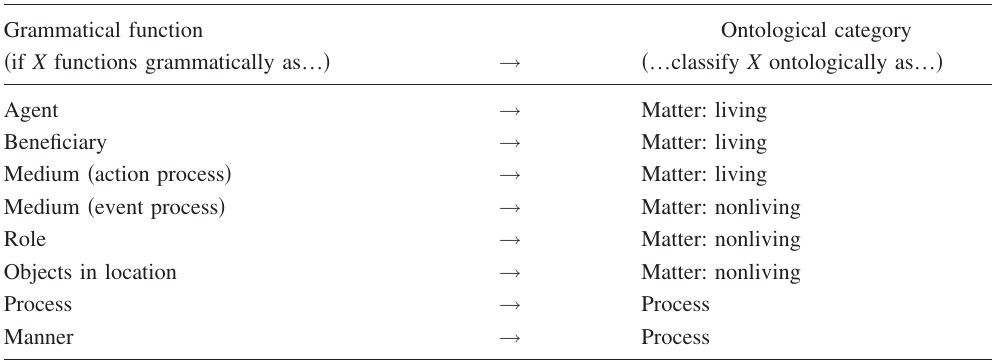
TABLE II. Summary of the mapping between grammar and ontological